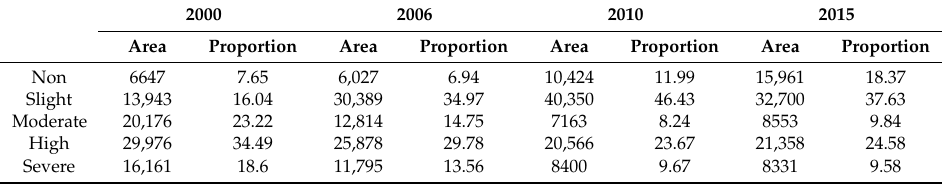
Table 2. The status of desertification in Ordos during various periods (area: km 2 ; proportion: